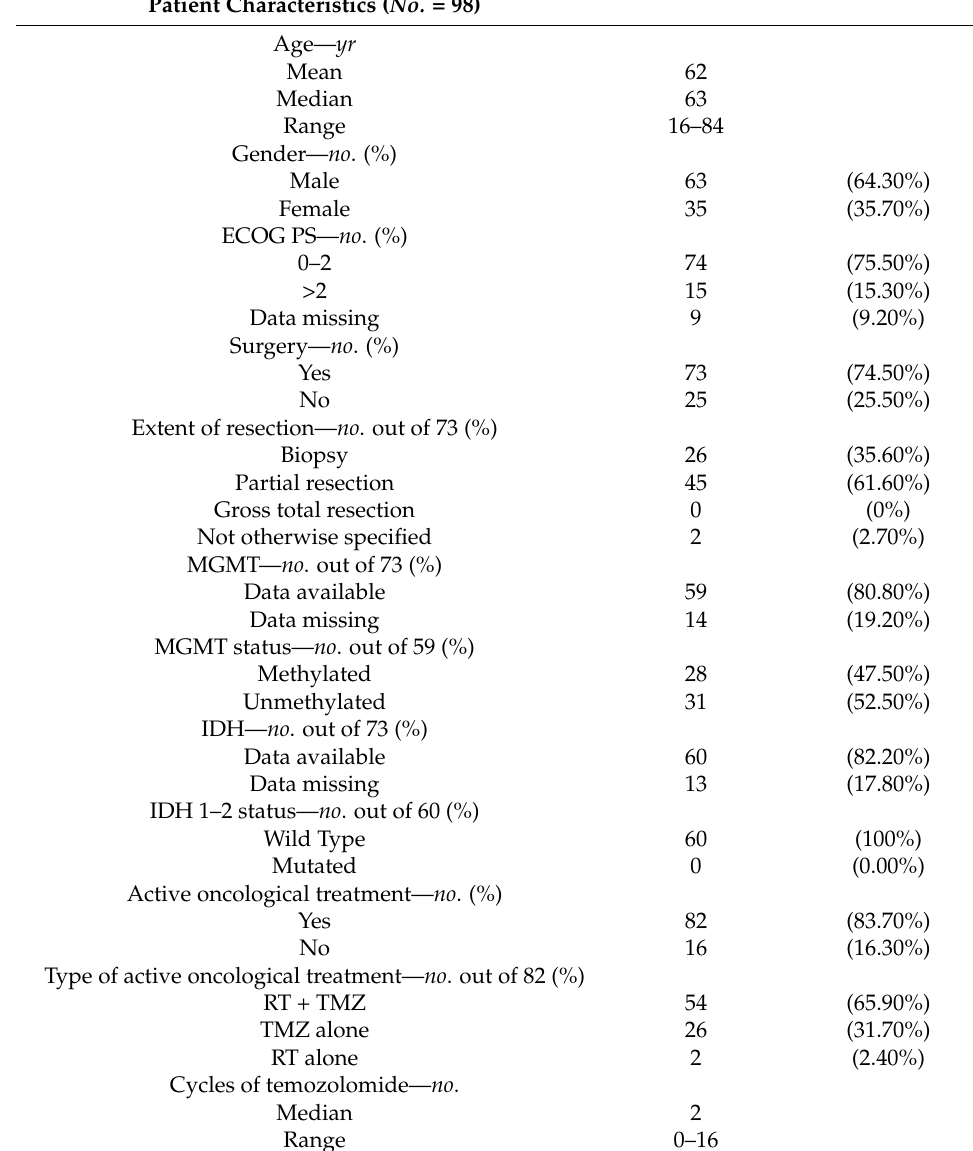
Table 1. Patients and treatment